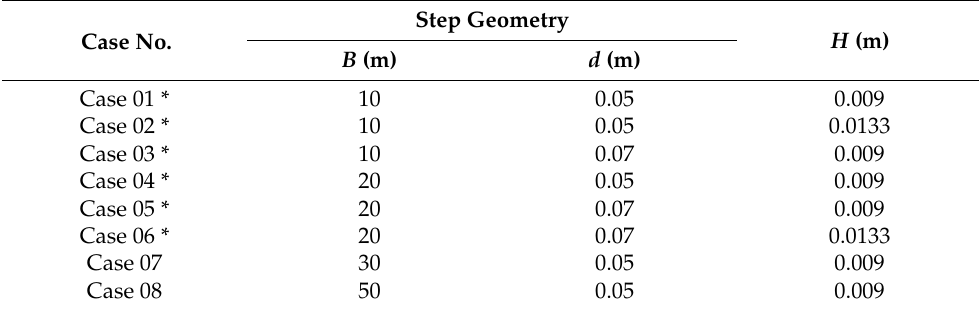
Figure 1. Illustration of setup of ( a ) experiments and ( b ) model simulations. Table 1. Summary of configuration of submerged steps and conditions of solitary wave of experi- ments and model simulations (e.g., working depth h of 0.1